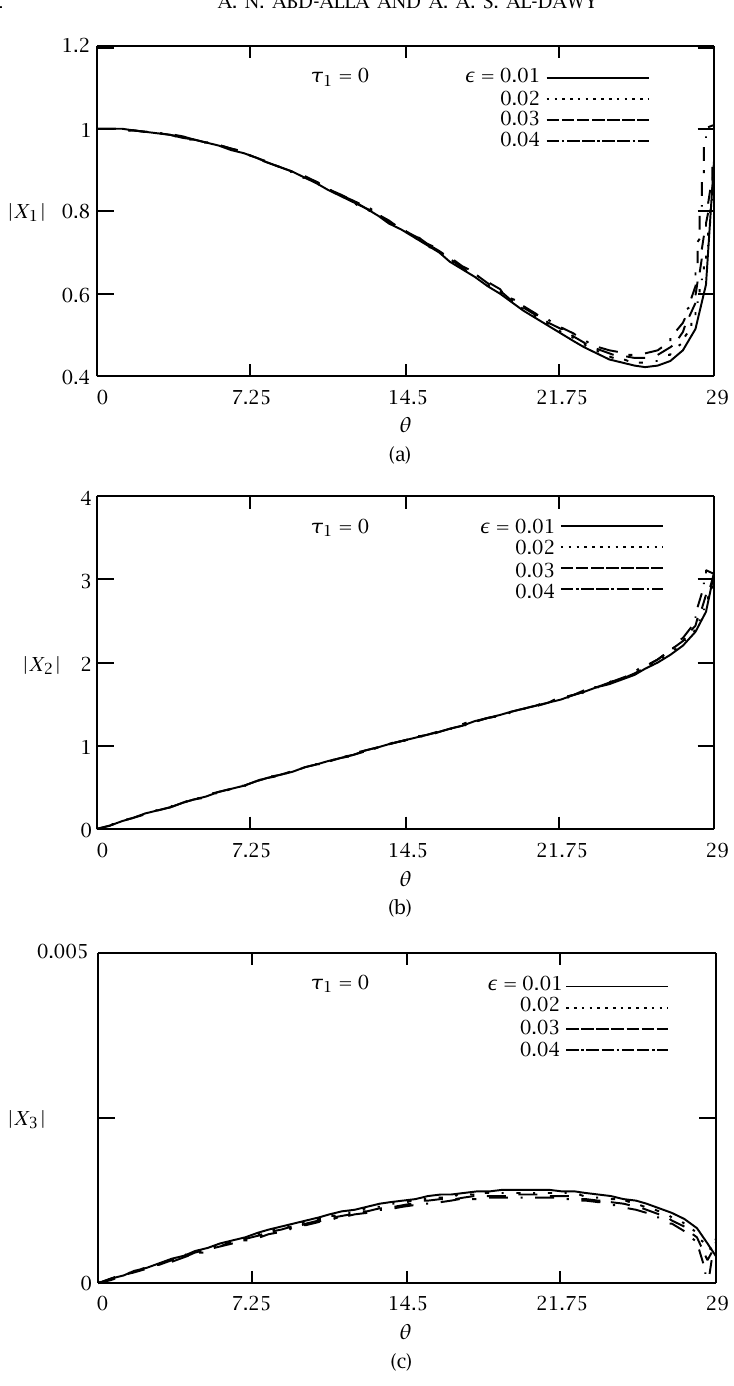
Figure 8 . (The effect of the thermal coefficient * in L-S theory) | X 1 | , | X 2 | , | X 3 | versus the angle of incidence θ